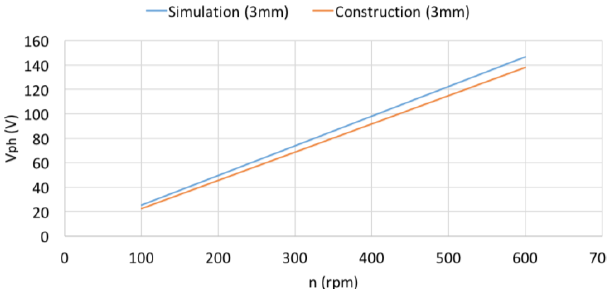
Figure 9. Plot versus the speed of the output phase voltage at no-load, simulation and experimental results.